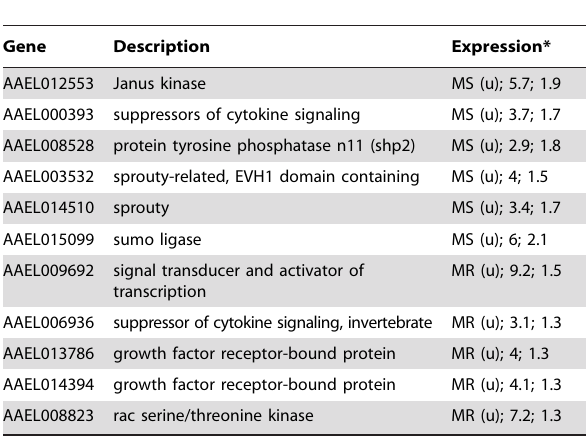
Table 4. List of JAK-STAT pathway